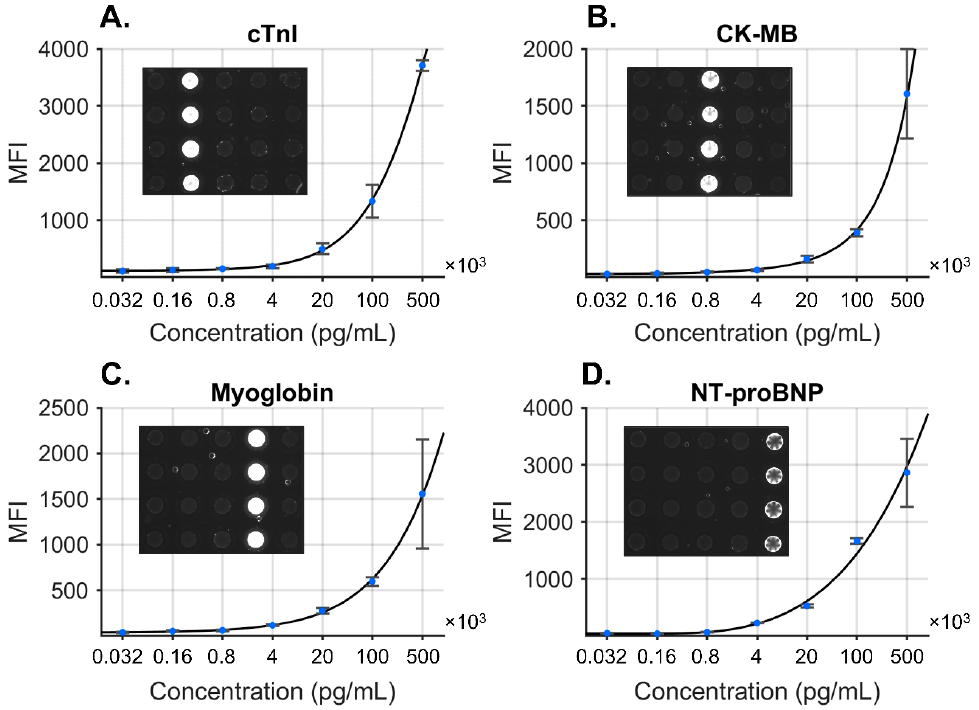
Figure 3. COVID-19 disease severity biomarker panel consisting of four biomarkers: cTnI ( A ), CK-MB ( B ), MYO ( C ), and NT-proBNP ( D ). Standard curves were fit to the concentration data, and specificity was demonstrated for each antigen at high concentration (inset images). Reproduced from [20] with permission from the Royal Society of Chemistry.